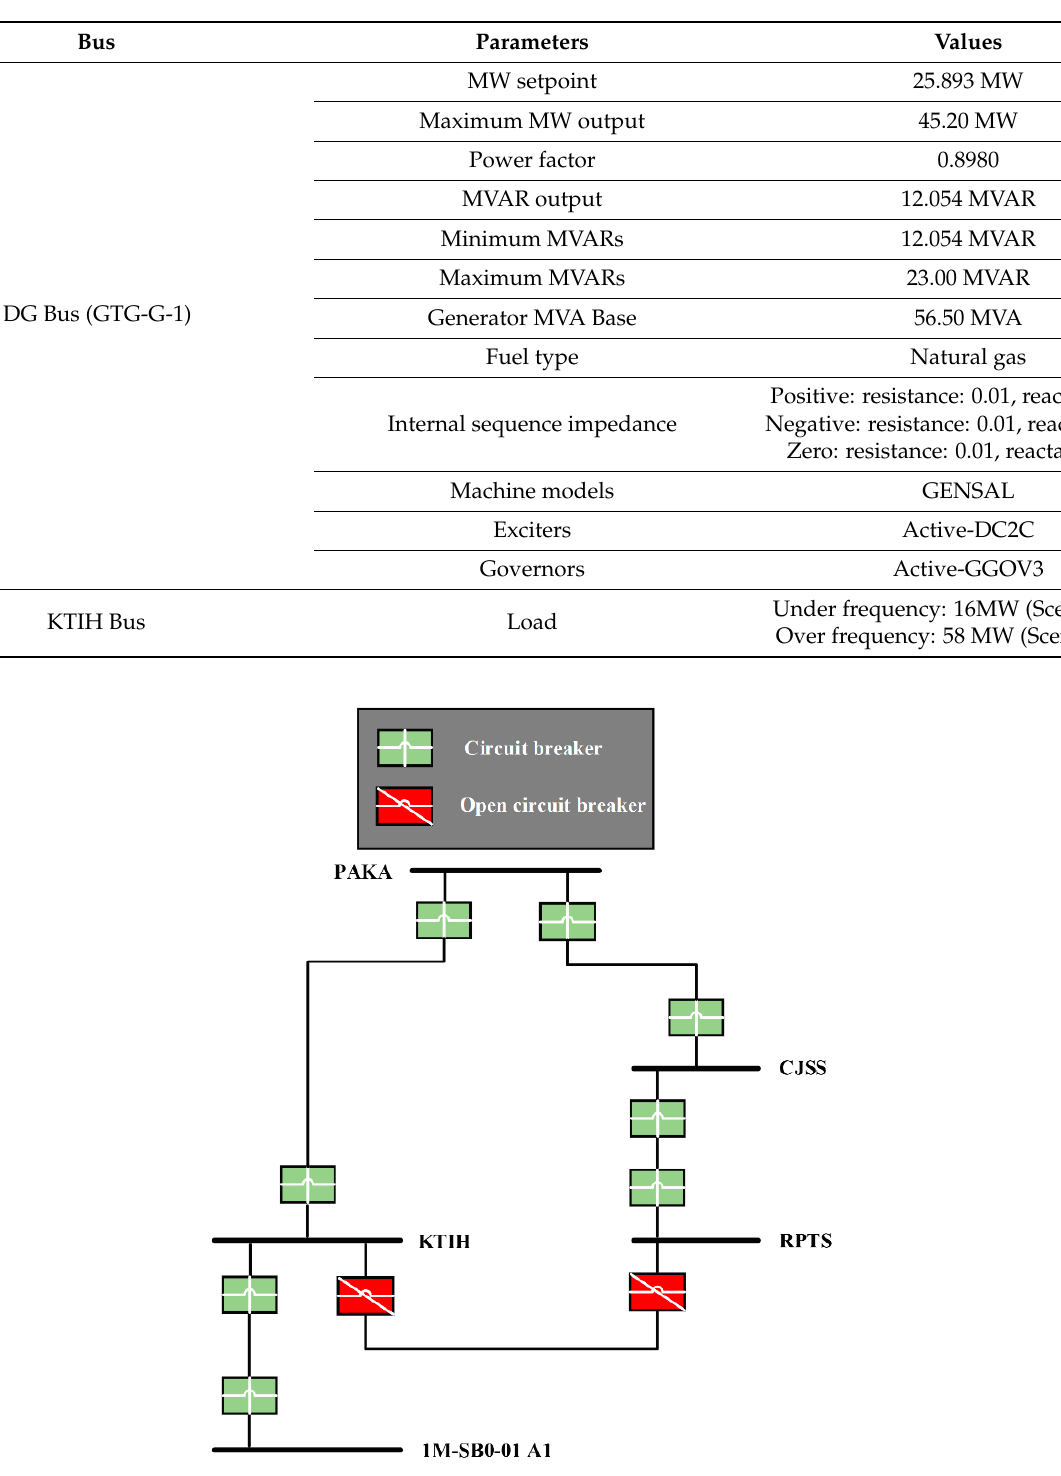
Figure 4. Islanding Scenario 2 of the test system.